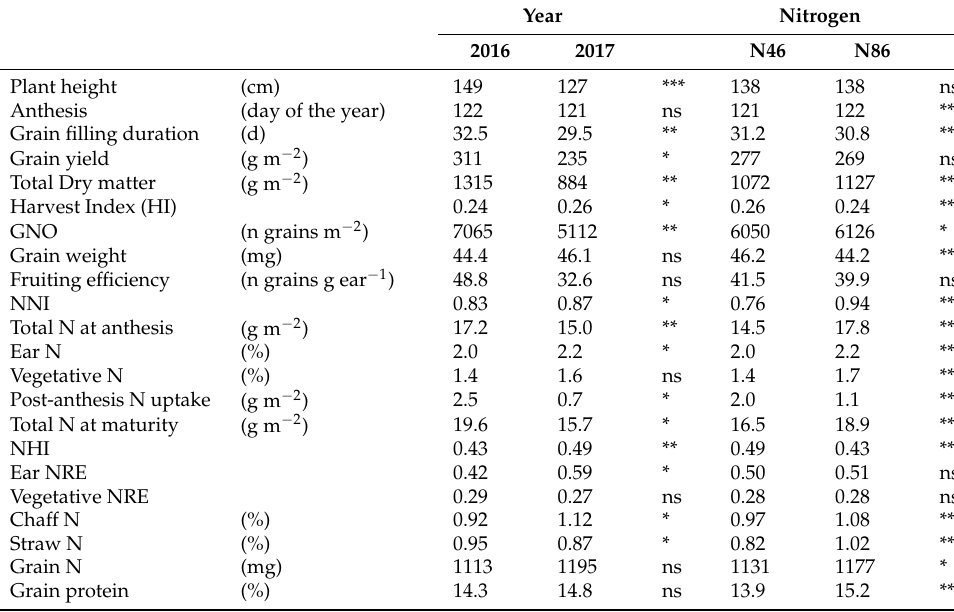
Table 4. Mean effects of Year and Nitrogen